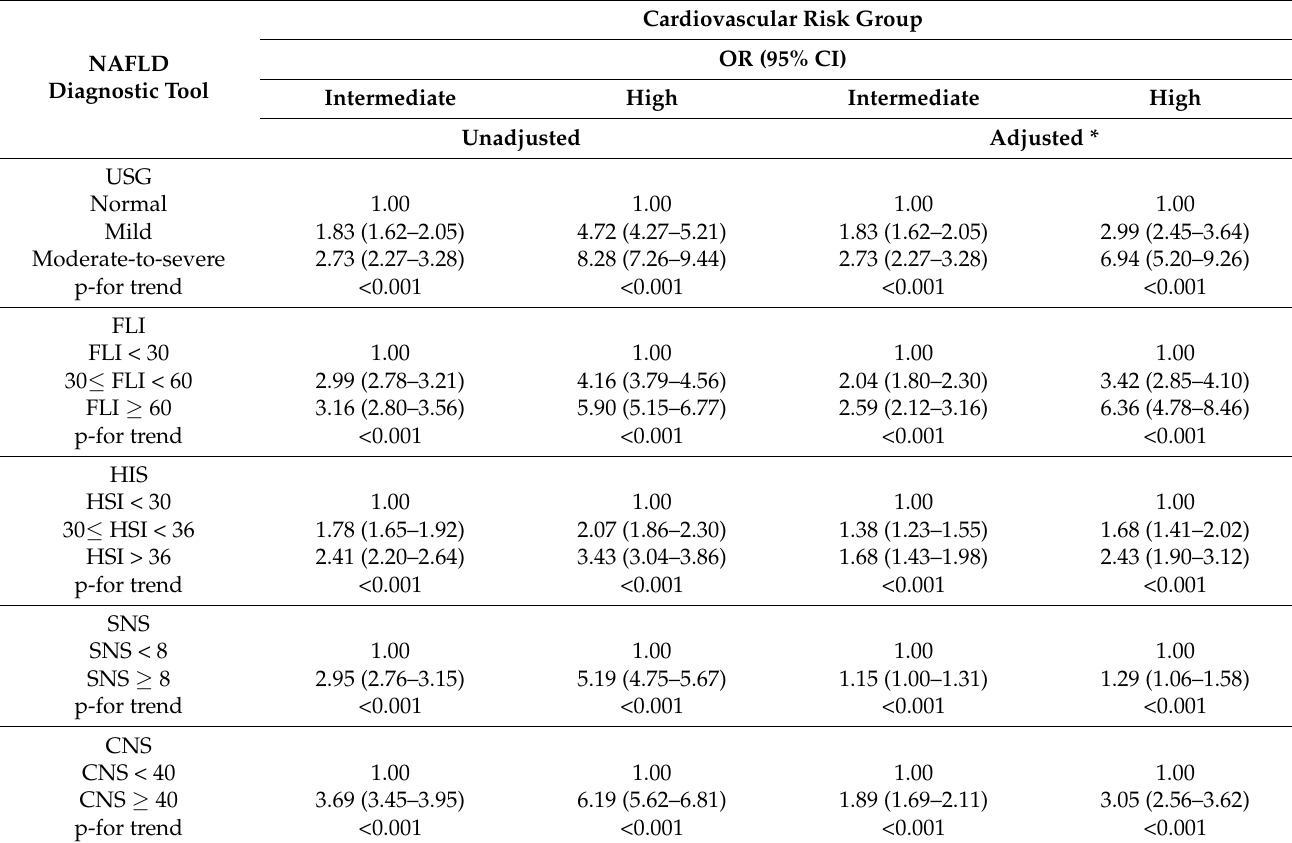
Table 3. Relationship between ultrasonography, NAFLD diagnostic tools, and cardiovascular risk groups.